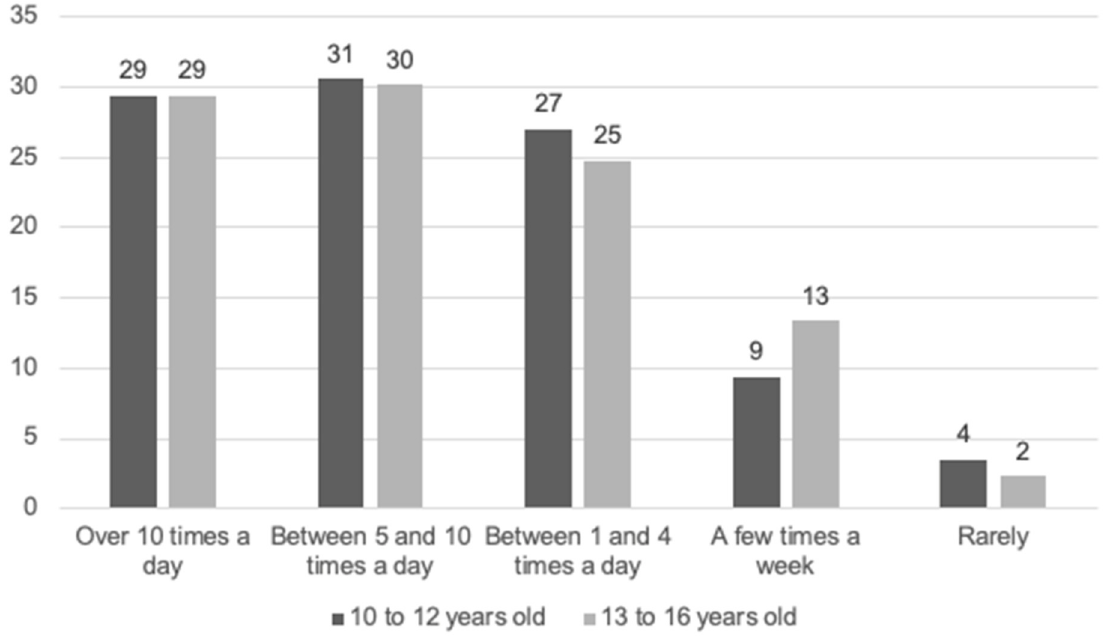
Figure 2. How frequently users open the TikTok app (in percentage).